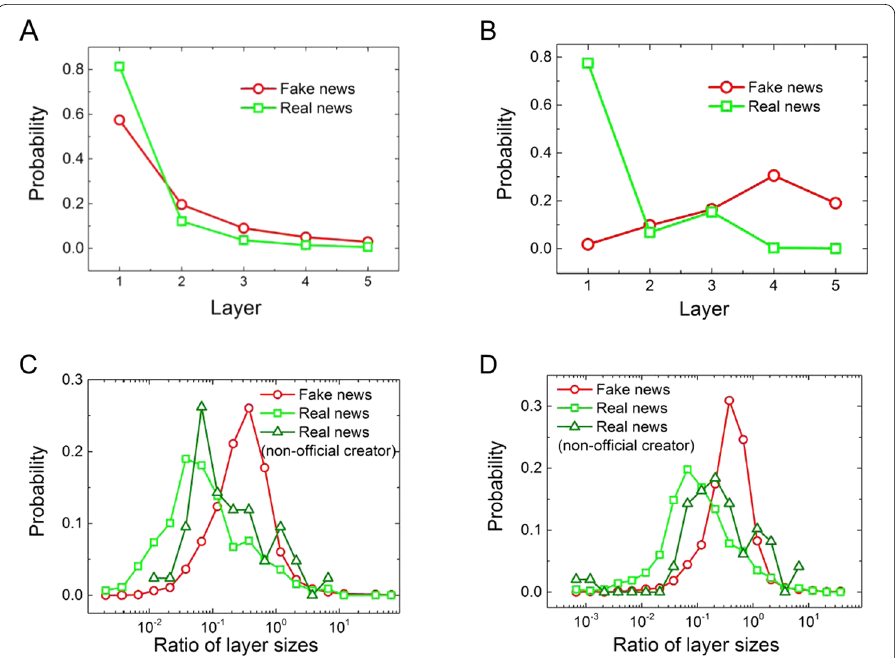
Figure 3 Ratio of layer sizes differentiates fake news from real news. The distribution of the ratio of layer sizes and its development after a period of time can differentiate fake news from real news. These differences appear already after a few hours. ( A ) The PDF of all re-postings in the first five layers averaged over all of the Weibo propagation networks. The p -value of Mann–Whitney is below 0.01. ( B ) The PDF of all re-postings in the first five layers in all networks of Twitter. The p -value of Mann–Whitney is below 0.01. ( C ) Distribution of the ratio of layer sizes at five hours from the first re-posting. The ratio of layer sizes is the size of the second layer divided by the size of the first layer. The p -value of Mann–Whitney between fake and real news is below 0.01. This figure considers all 1701 fake news, all 492 real news and 51 real news with non-official creators at five hours from the first re-posting. ( D ) Distribution of the ratio of layer sizes of all re-postings for the whole lifespan. The p -value between fake and real news is below 0.01. Here we consider all available Weibo propagation networks (all 1701 fake news, all 492 real news and 51 real news with non-official